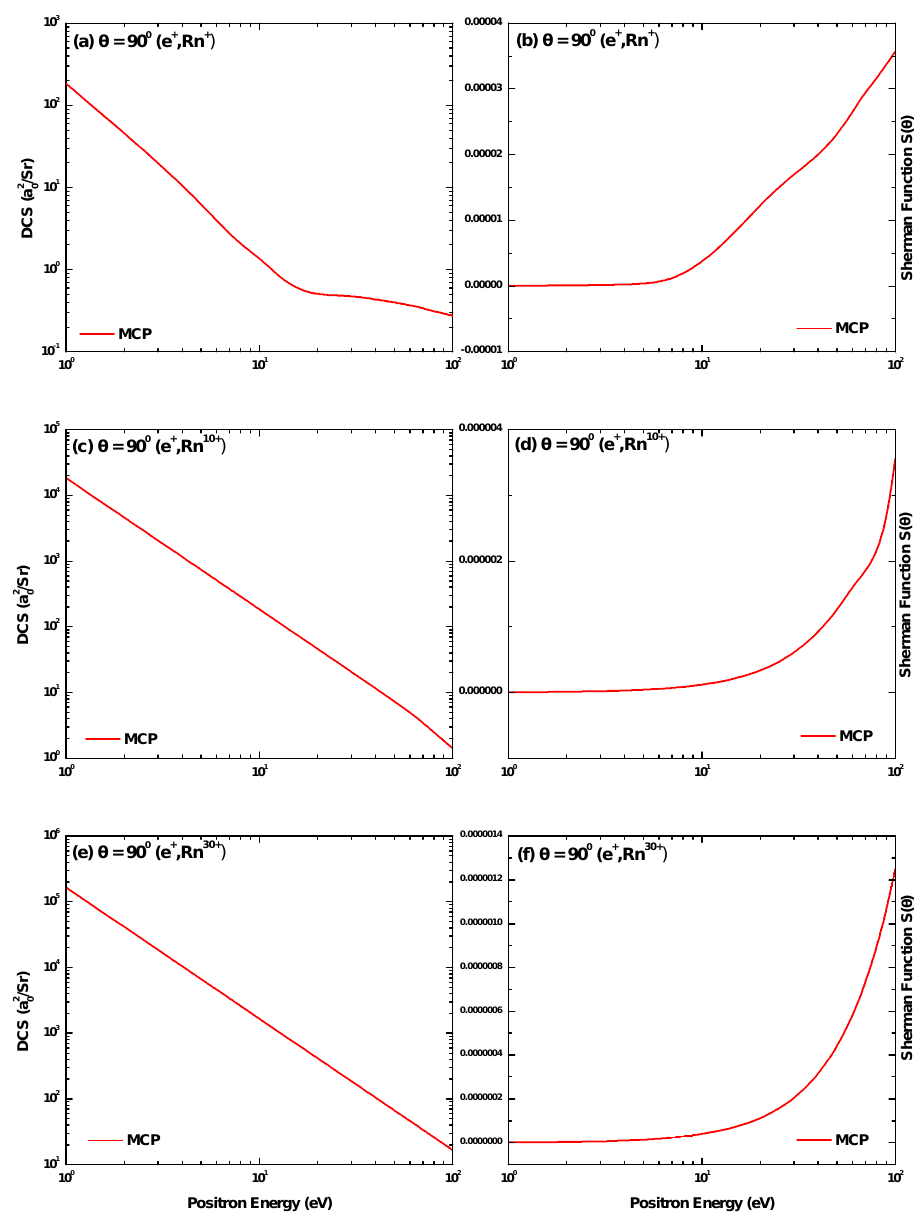
Figure 28. Energy dependent DCS and corresponding Sherman function for positrons elastically scattered from ( a , b ): Rn + , ( c , d ): Rn 10 + and ( e , f ): Rn 30 + at fixed scattering angle θ = 90 ◦